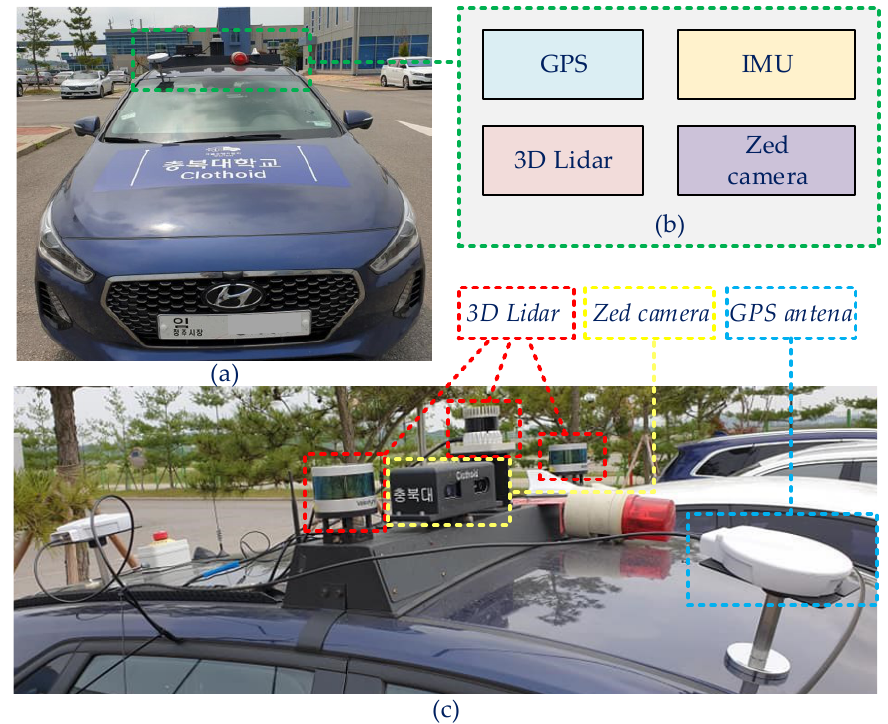
Figure 9. ( a ) Hyundai I-30 platform, ( b ) the perception with 3D LiDAR, Zed-camera, GPS and Inertial Measurement Unit (IMU), ( c ) the sensors